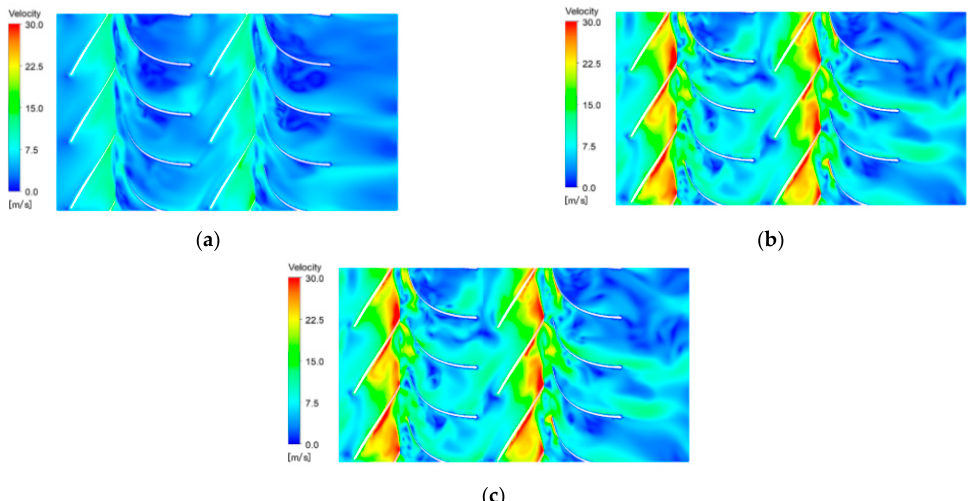
Figure 20. Velocity distribution on first-stage impeller-guide vane B2B view: ( a ) n = 900 r/min; ( b ) n = 1450 r/min; ( c ) n = 1800 r/min.